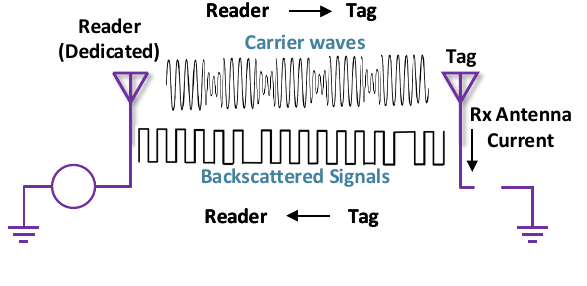
Figure 7. Dedicated